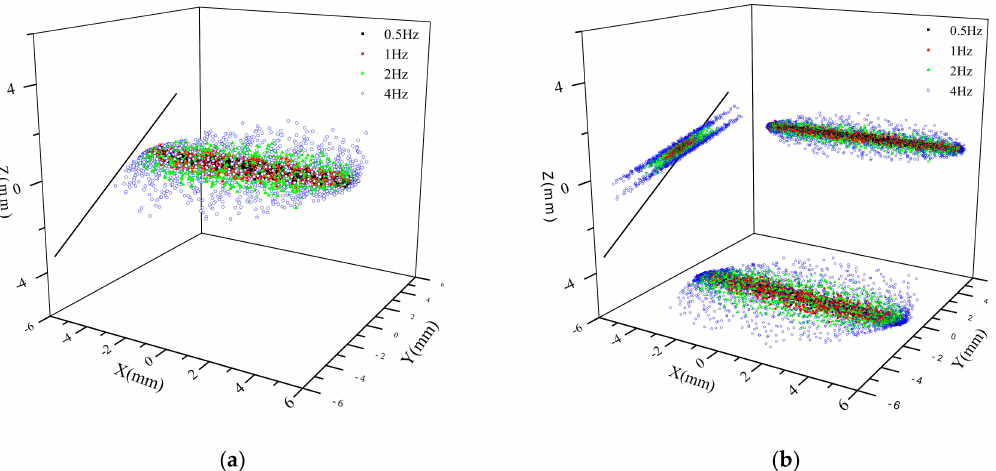
Figure 14. Distribution of discrete points. ( a ) Data at discrete points at 0.5, 1, 2, and 4 Hz; ( b ) projections of discrete points on the XY , XZ , and YZ